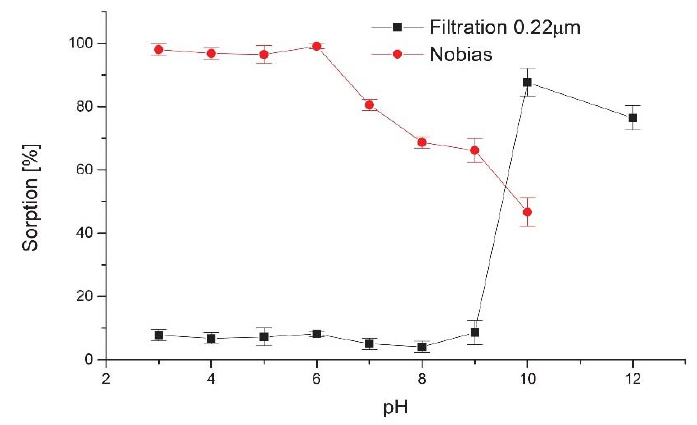
Figure 1. The effect of pH on the sorption of 44 Sc(III) ions on 10 mg Nobias resin and precipitation on a 0.22 μ m filter.